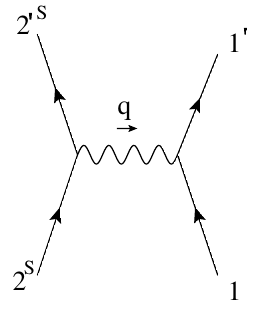
Figure 1 . The exchange of a photon between a spin- S and a scalar